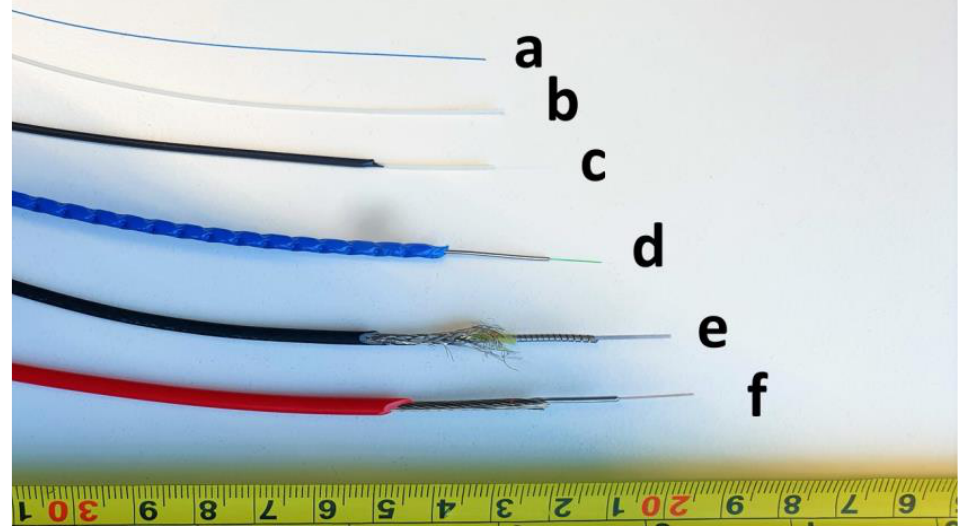
Figure 1. Cable types (a) bare fibre, (b) 0.9 mm tight buffered, (c) 2.0 mm tight buffered, (d) 3.2 mm